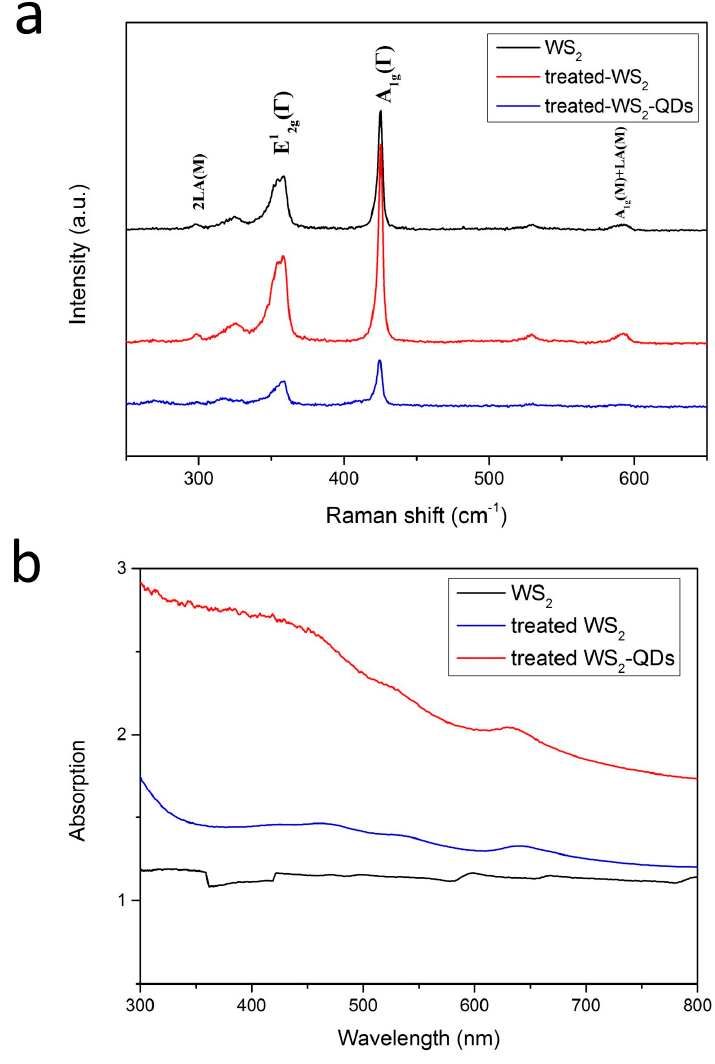
Figure 4. ( a ) Raman spectra and ( b ) UV-vis (ultraviolet-visible) spectra of WS 2 , sulfuration-treated WS 2 and treated WS 2 QDs, respectively.